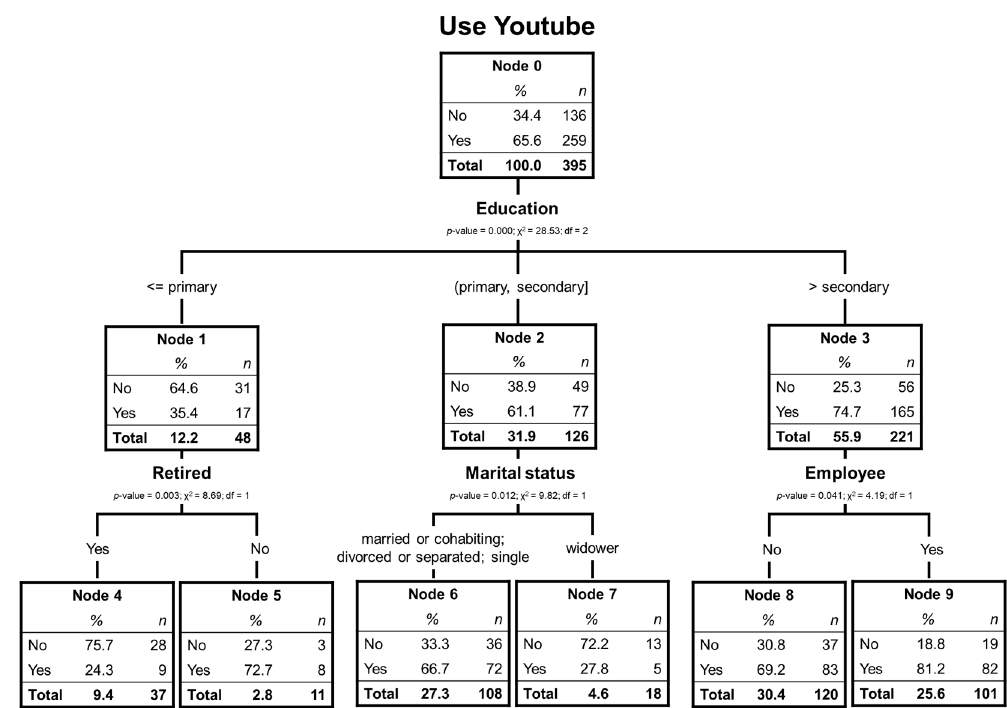
Figure 1. Decision tree of elderly YouTube users. Table 1. Estimation risk for using YouTube (CHAID method).